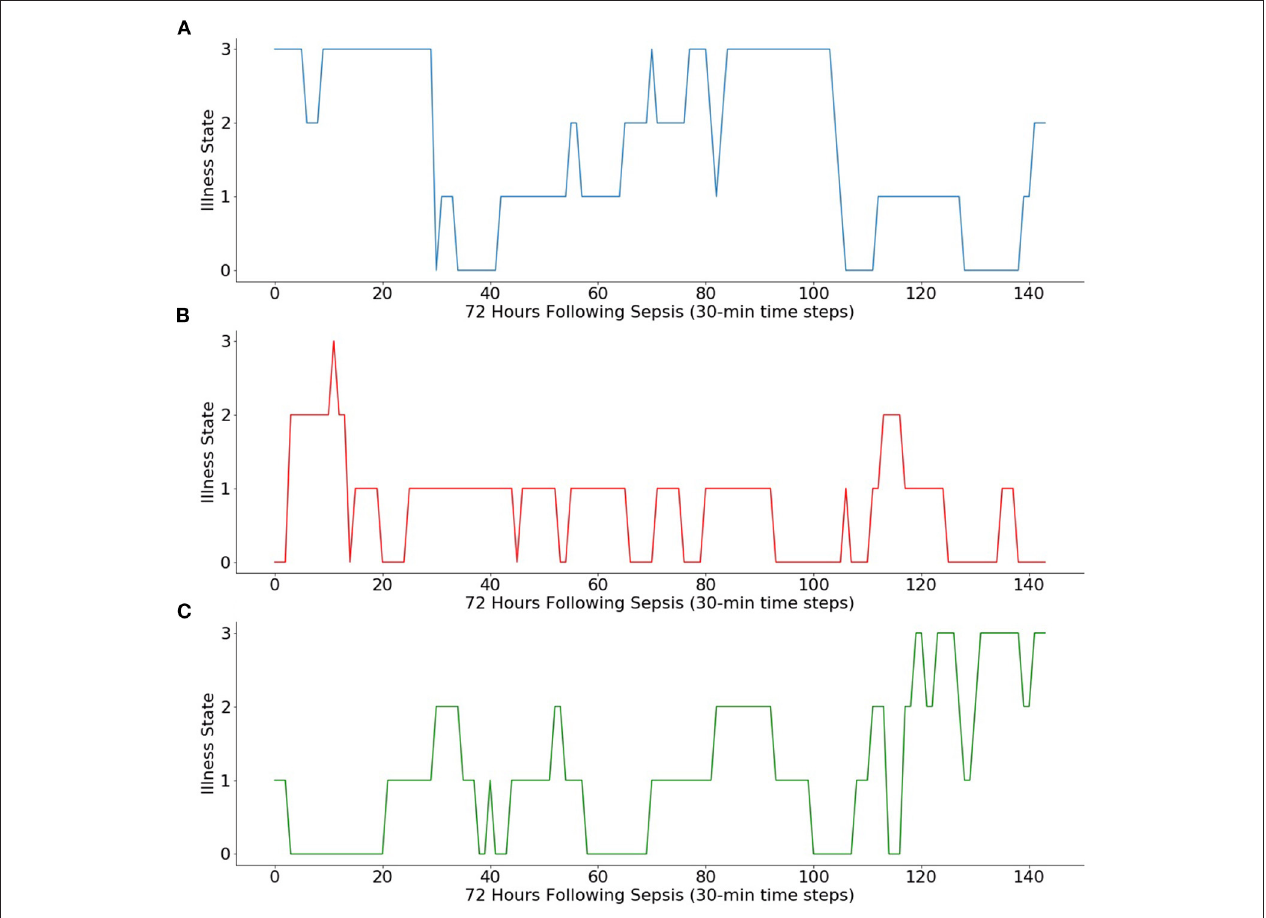
FIGURE 2 | Simulations of Markov chain iterations from three initial illness states. Using the Markov chain, 3 days of transitions (i.e., 144 sequential 30-min transitions) are simulated from (A) initial illness state of 3, (B) initial illness state of 0, and (C) initial illness state of